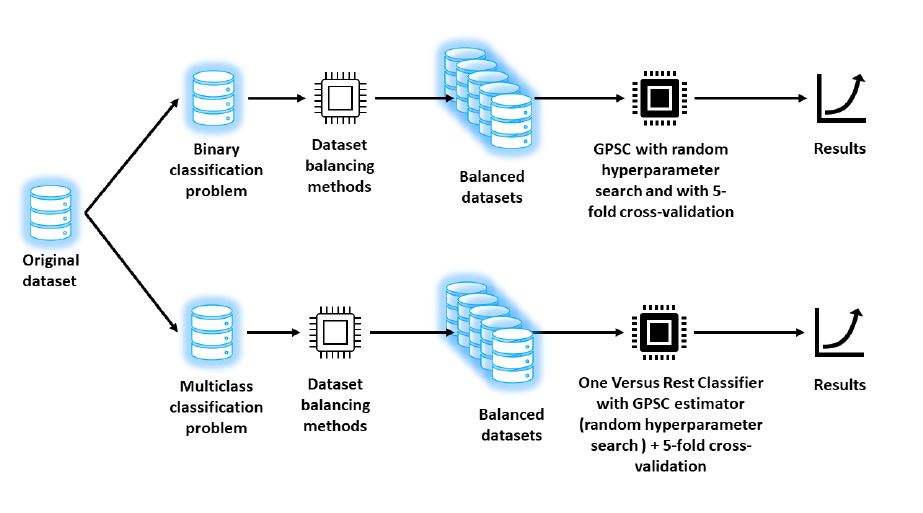
Figure 1. The schematic view of research methodology